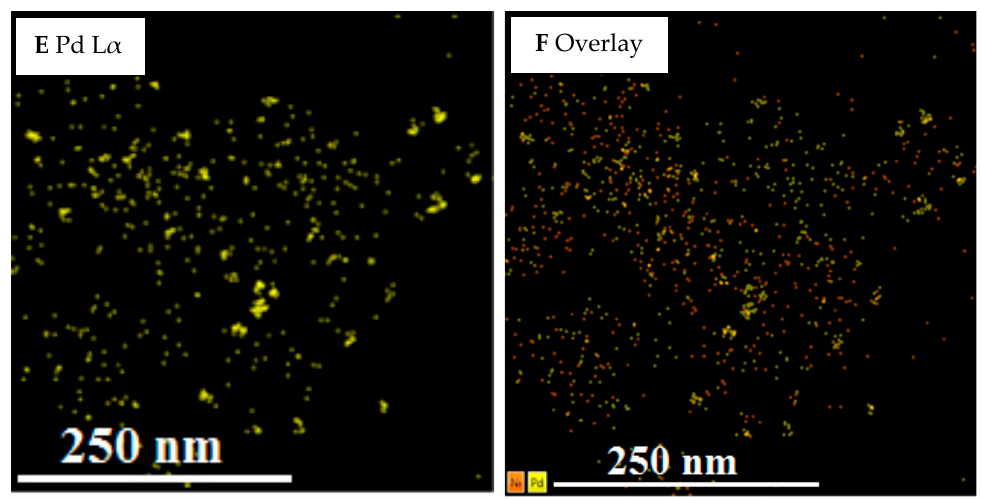
Figure 3. ( A ) TEM image, ( B ) PdNi size distribution, ( C ) STEM-HAADF image, and ( D – F ) EDS elemental mapping images of PdNi/UiO-66-NH 2 (1:1).